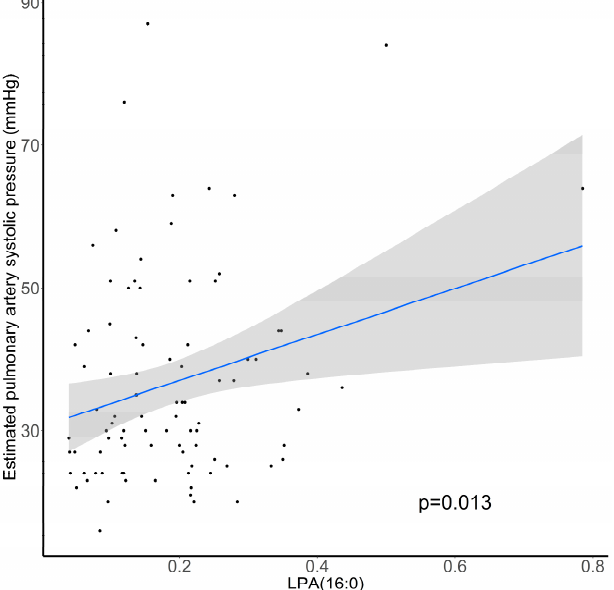
Figure 7. Association between estimated pulmonary artery systolic pressure (mm Hg) and relative abundance of plasma LPA(16:0). N = 90, p -value computed by Student’s t -test.